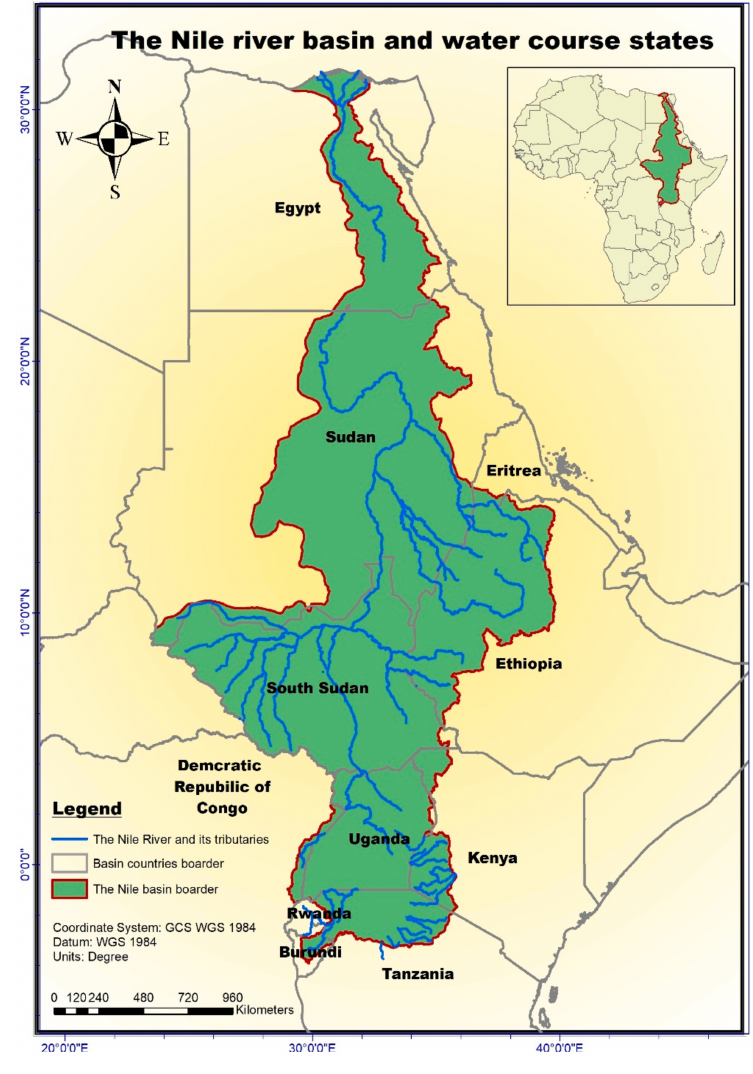
Figure 1. Map of the Nile